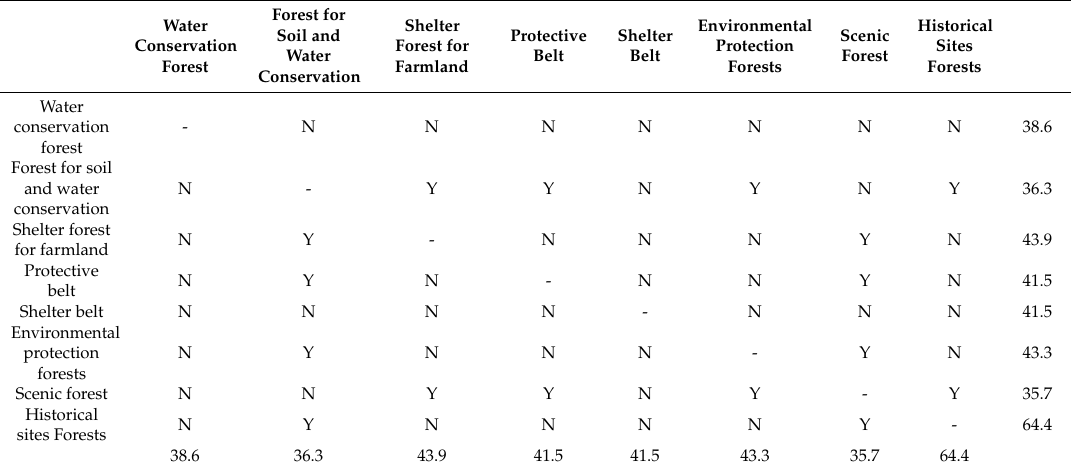
Table A2. Tukey’s HSD test for the forest category factor (Y means the testing is significant at the 0.05 level, and N represents an insignificant di ff erence).